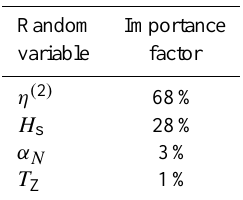
Table 2. Importance factors for c max /H s > 1 .